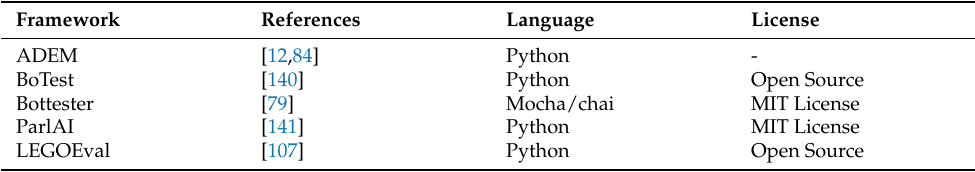
Table 6. Frameworks for evaluating conversational interfaces in the selected pool of primary